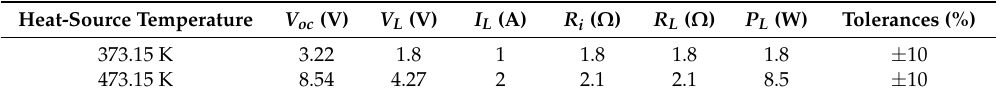
Table 1. Specifications of heat-stove TEG.